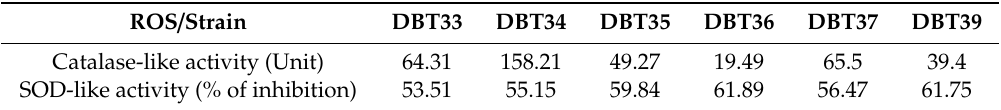
Table 1. Catalase and SOD like activity in a 50 µ g / mL methanolic extract obtained from six di ff